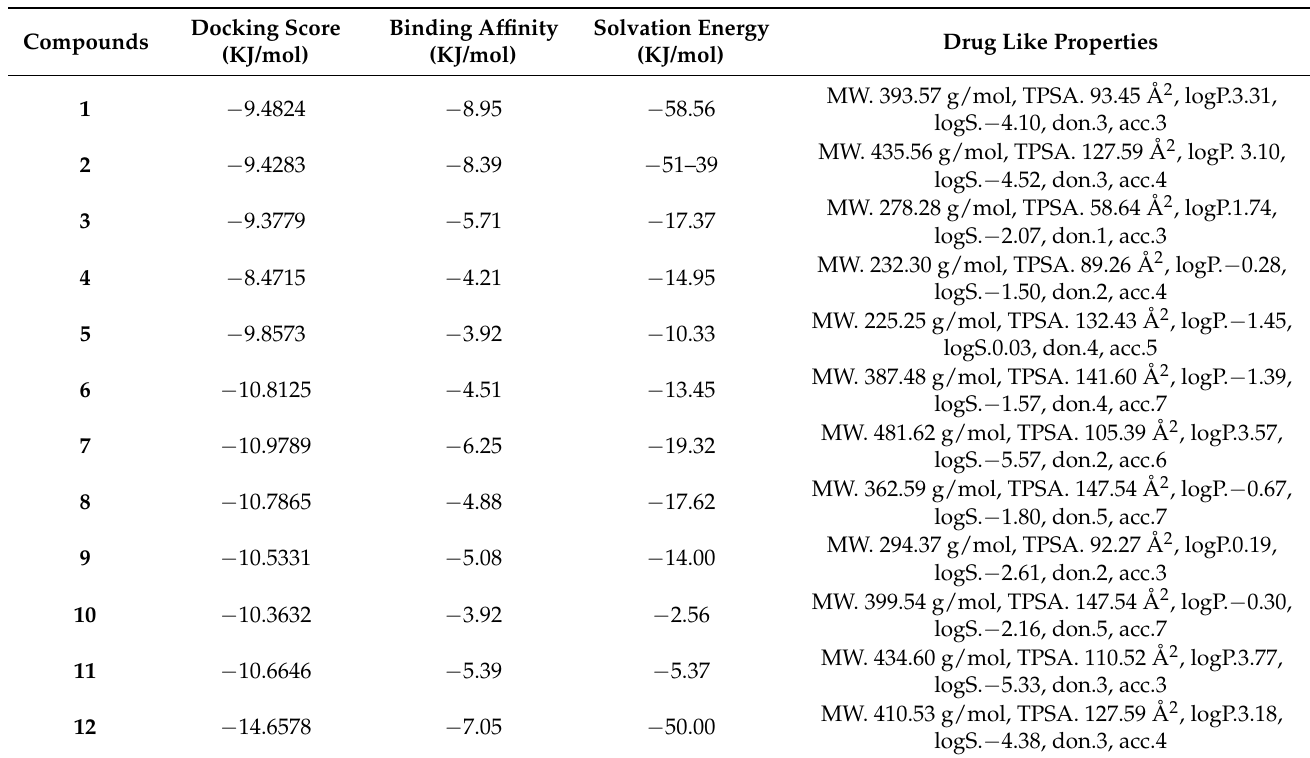
Table 1. Docking Scores, binding energies, binding affinities, and drug like properties of the novel chemical